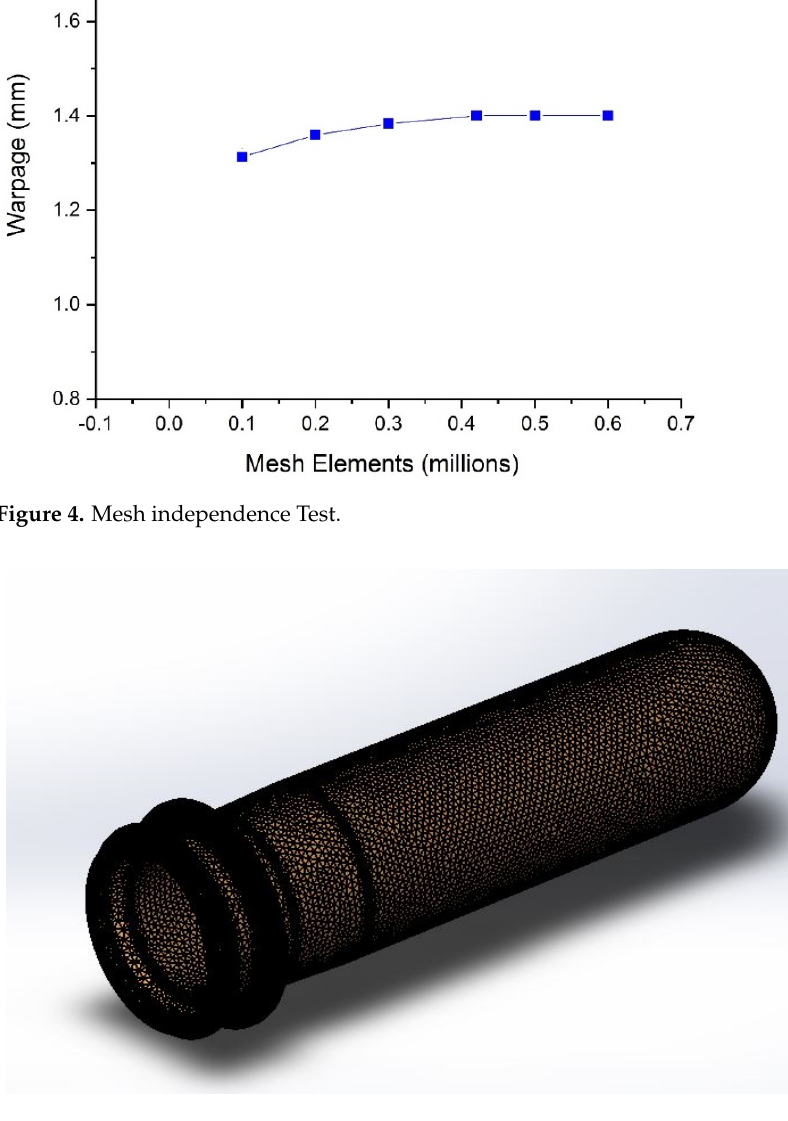
Figure 5. Mesh Generated for the 28 g Preform.